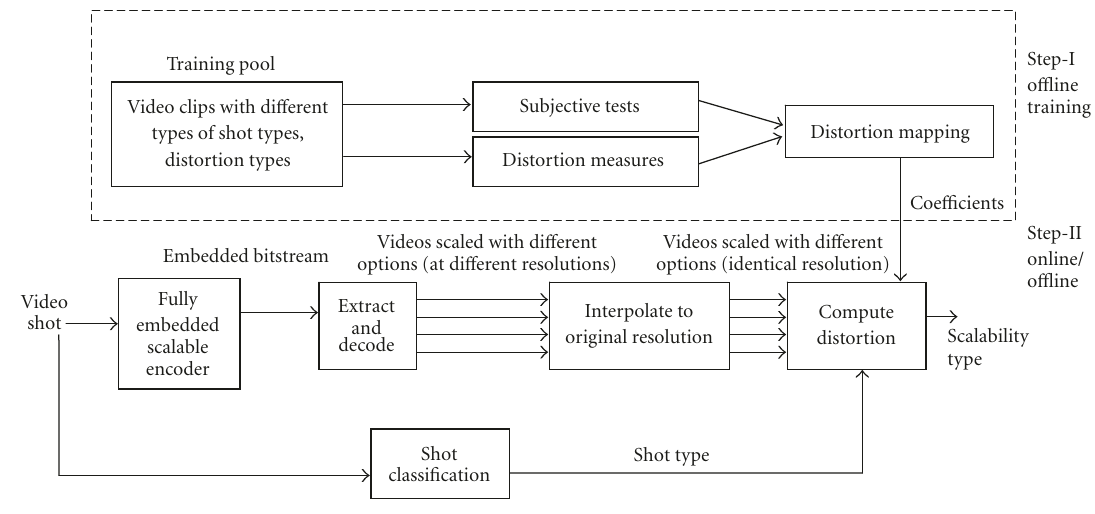
Figure 3: Overview of the proposed algorithm for scaling-type